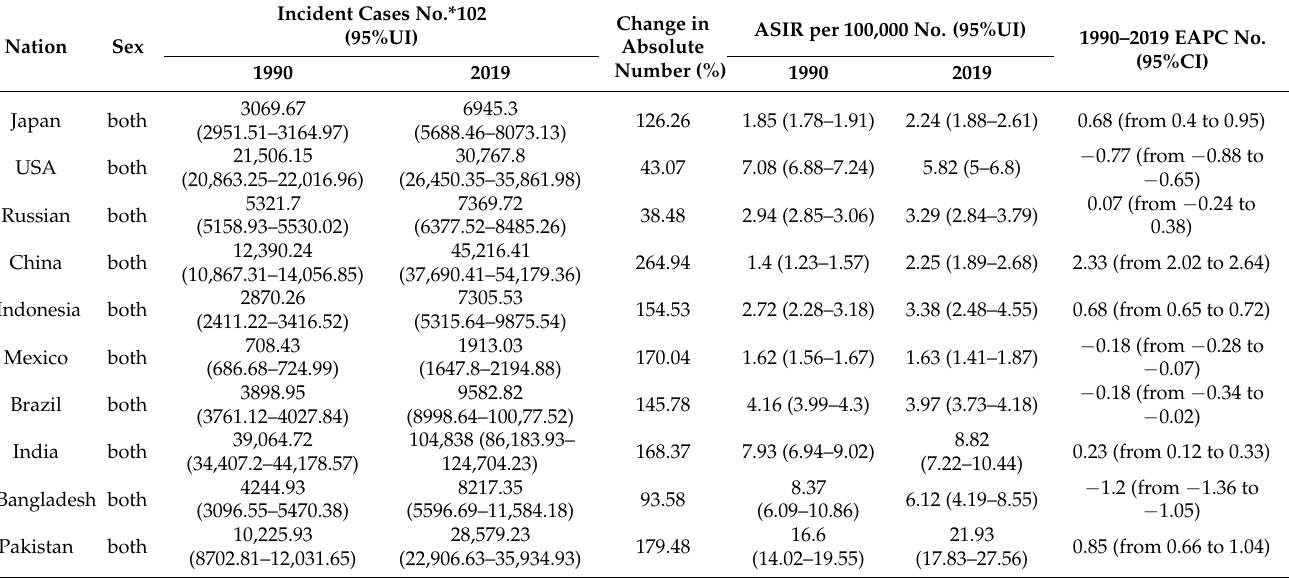
Table 1. The incident cases and age-standardized incidence rate of oral cancer in 1990 and 2019, and its temporal trends from 1990 to 2019. (Countries are ranked from highest to lowest in